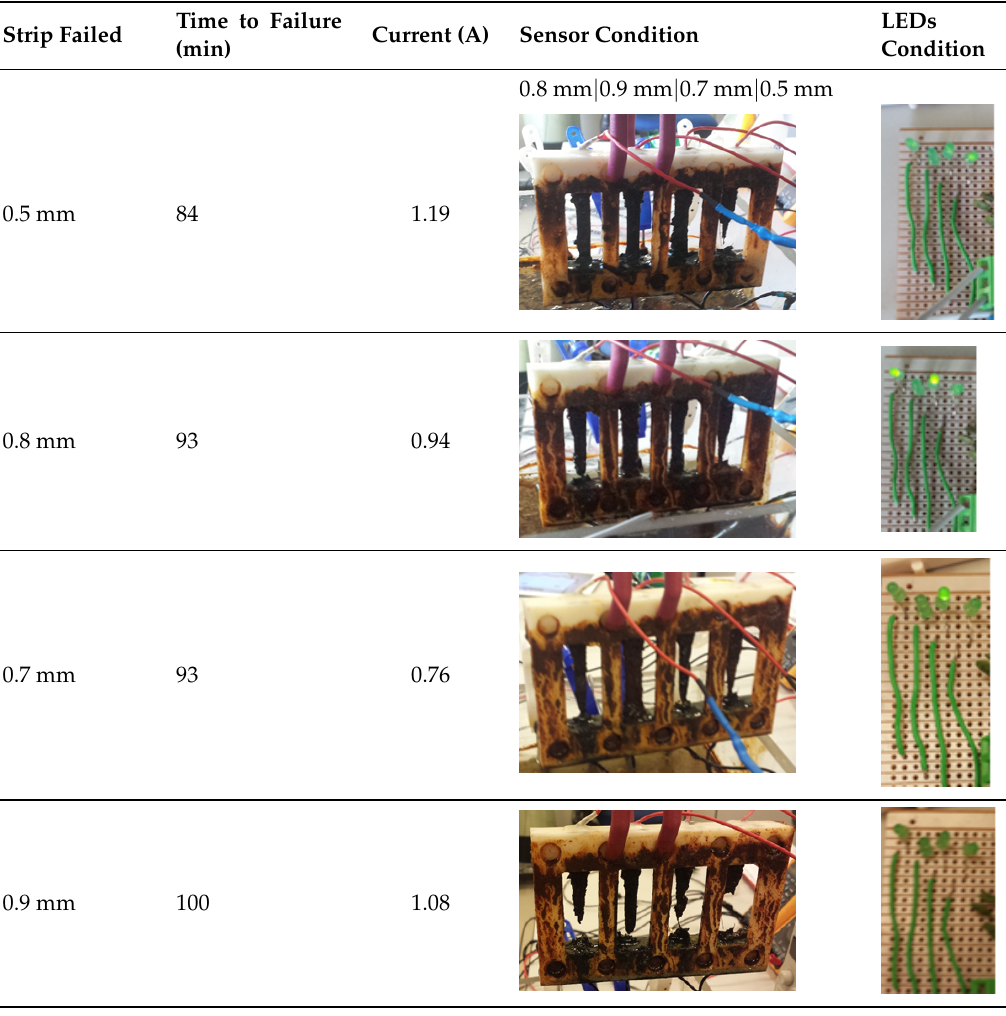
Table 2. Time to failure of each strip, initial current measured through each strip and an image of